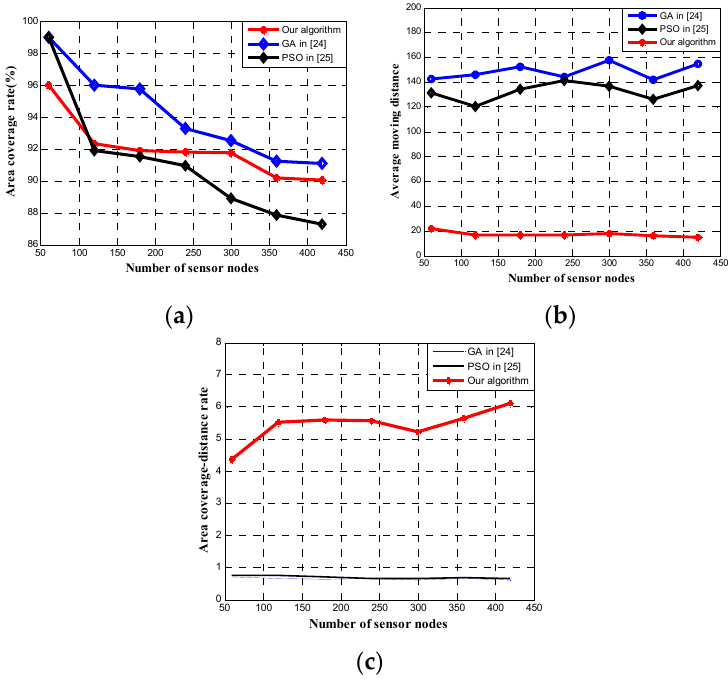
Figure 8. Results of the three algorithms on hybrid WSNs with different number of sensor nodes. ( a ) Area coverage rate of the three algorithms; ( b ) average moving distance of the three algorithms; ( c ) area coverage–distance rate of the three algorithms.